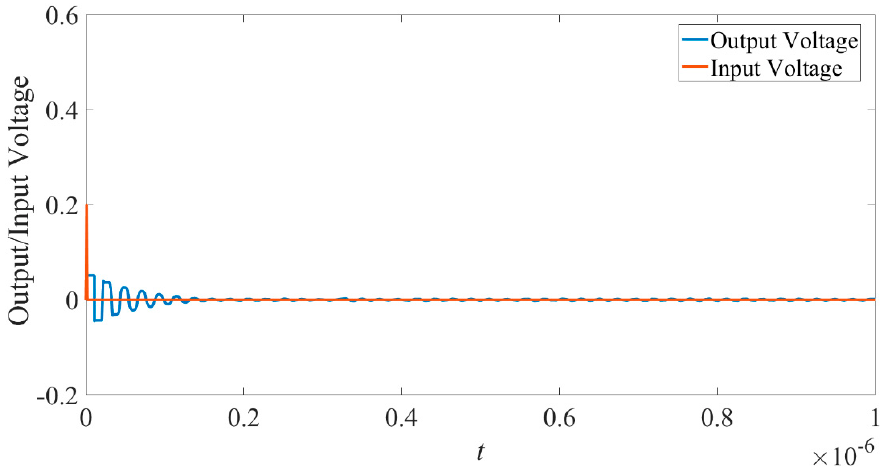
Figure 10. Subthreshold response of the neuristor. It can be seen that the output voltage value is very small and degenerated. The situation is much like that in Figure 2. It shows that when the input voltage is less than the threshold, almost nothing